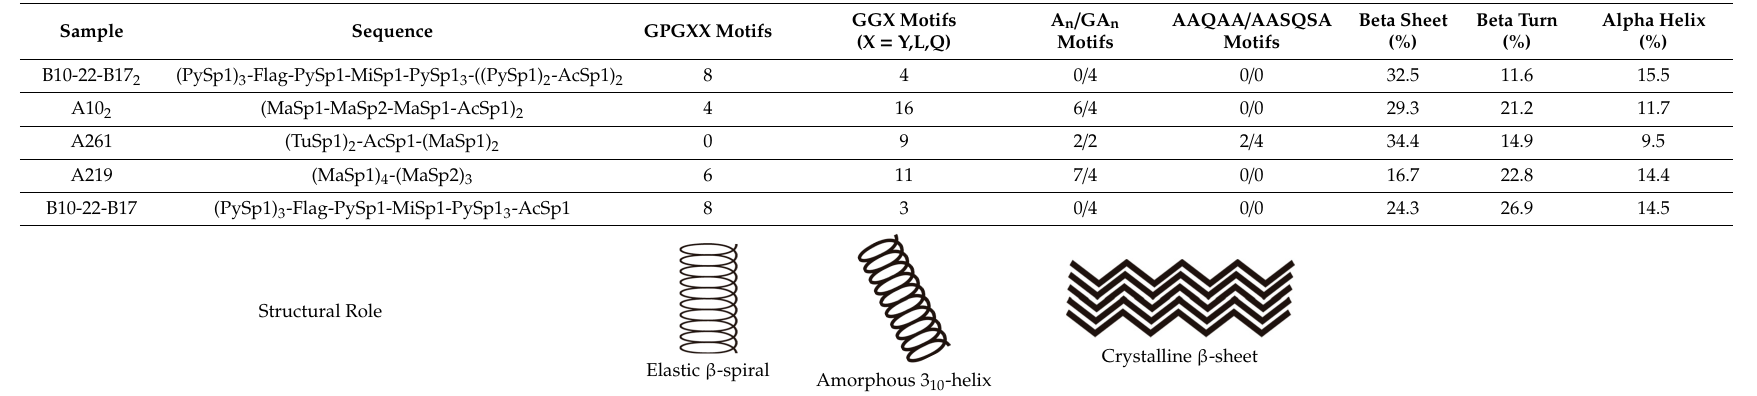
Table 3. Summary table of secondary structural motif counts determined from primary protein sequence for five select recombinant protein films (B10-22-172, A102, A261, A219, B10-22-17) along with their percentage secondary structure after methanol exposure determined from FTIR